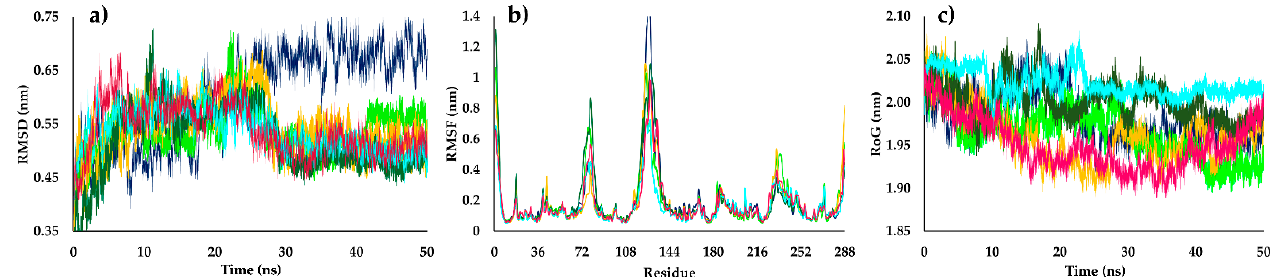
Figure 6. ( a ) Root-mean-square deviation (RMSD), ( b ) root-mean-square-fluctuation (RMSF), and ( c ) radius of gyration (RoG) values within the Lb PTR1 binding site, obtained after molecular dynamics simulations using three of the best-ranked structures in molecular docking calculations. apo Lb PTR1 (blue); DHB: Lb PTR1 complex (light green); PMA: Lb PTR1 complex (sky blue); structure 135 : Lb PTR1 complex (pink); structure 302 : Lb PTR1 complex (yellow); structure 302a : Lb PTR1 complex (dark green).